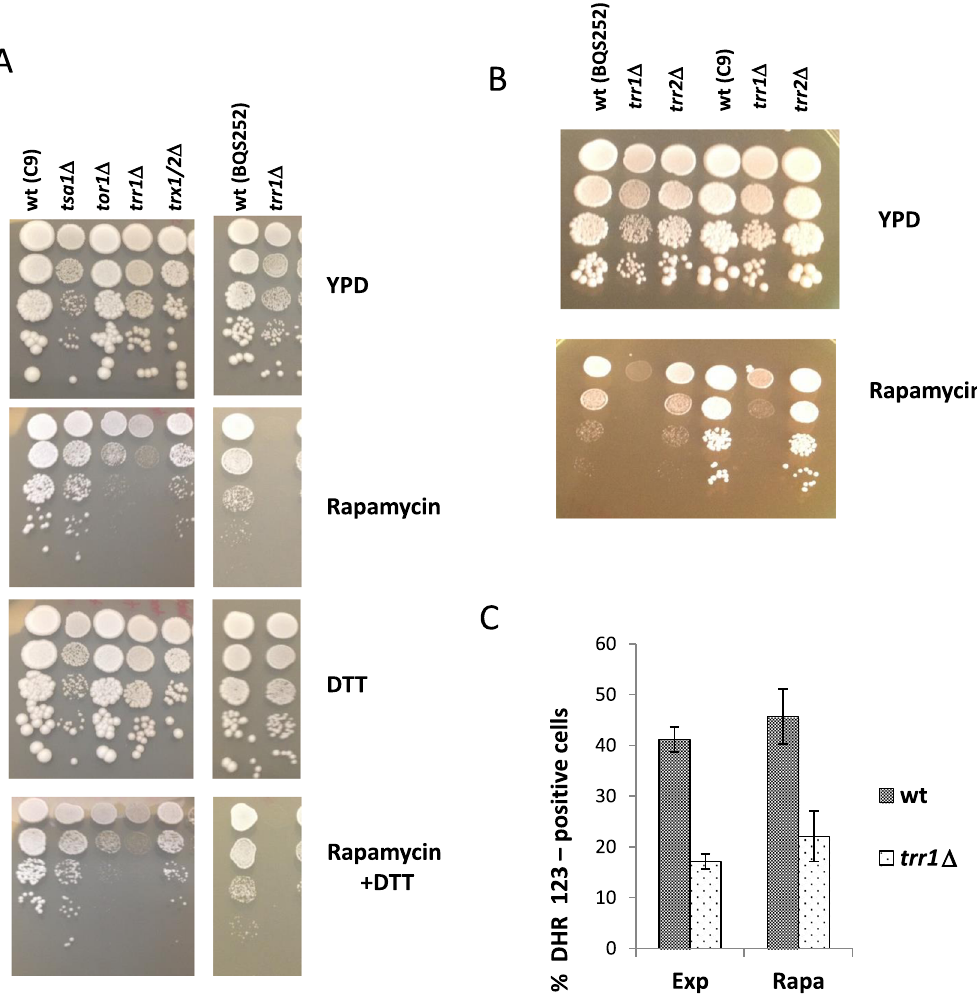
Figure 4. Trr1p is required for tolerance to rapamycin. ( A ) The spot analysis of sensitivity to rapamycin of mutants tor1 Δ , tsa1 Δ , trx1 Δ trx2 Δ and trr1 Δ in the C9 strain. The YPD plates that contained 100 nM rapamycin, 1 mM DTT, or both, were used. Strain BQS252 and its trr1 Δ mutant were also included. ( B ) A spot analysis of rapamycin sensitivity of the trr2 Δ mutant in both genetic backgrounds. ( C ) Intracellular ROS in BQS252 and its trr1 Δ mutant during exponential growth with or without